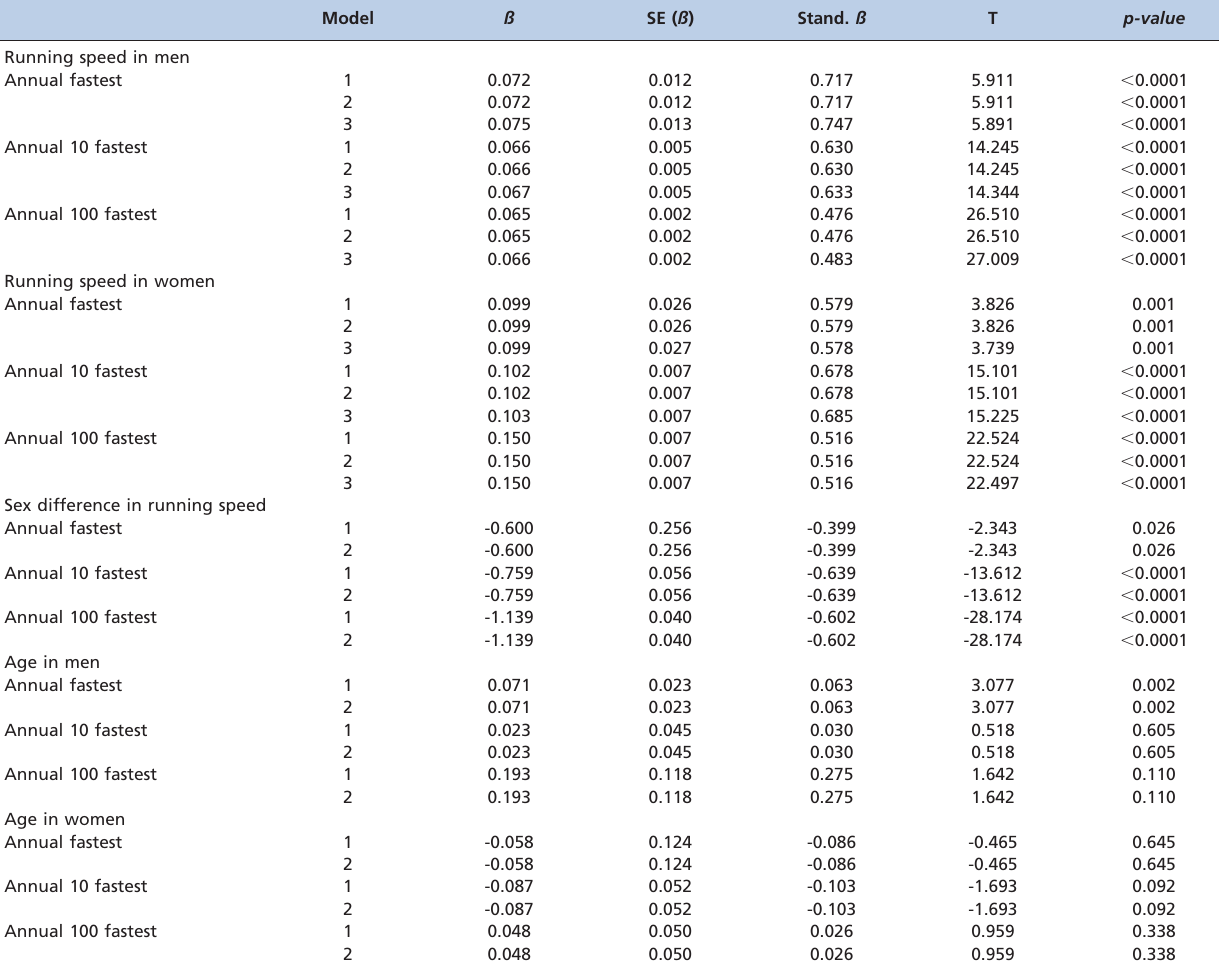
Table 2 - Multi-level regression analyses for changes in running speed over time, sex differences in running and ages of finishers (Model 1), with corrections for multiple finishes (Model 2) and ages of athletes with multiple finishes (Model 3).